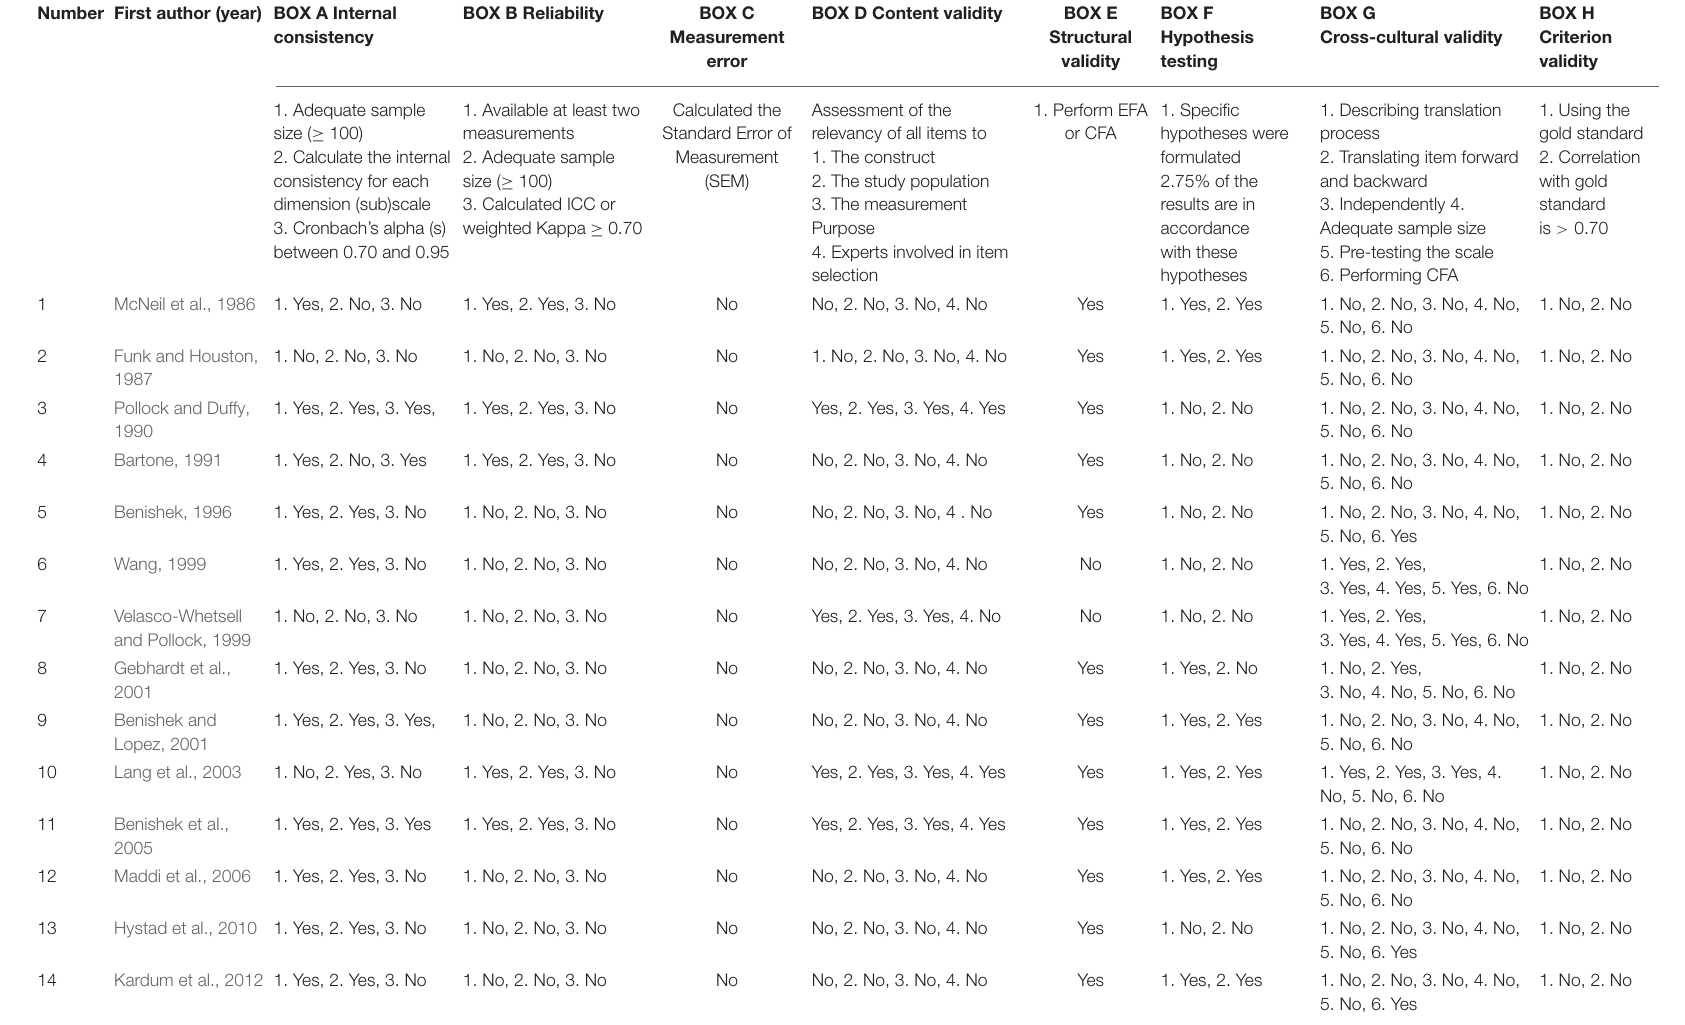
TABLE 3 | COSMIN quality